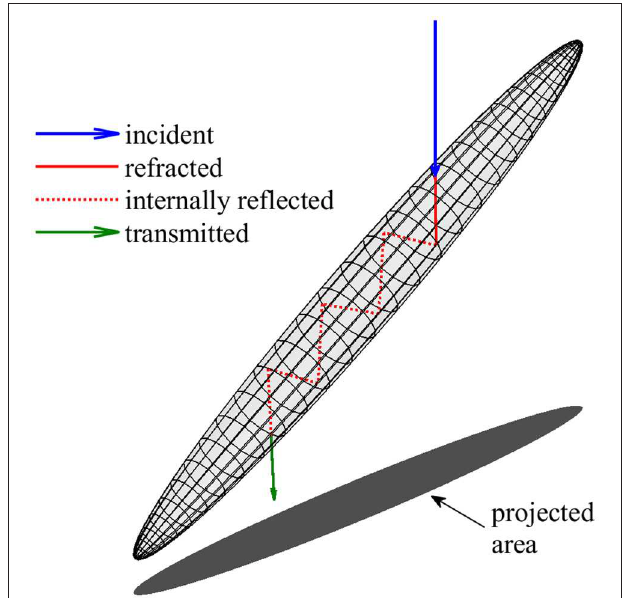
FIGURE 2 | Illustration of the geometric optics model used to estimate absorption by diatom colonies. Cells and colonies are represented by prolate spheroids with major axes, minor axes, and orientation determined from image analysis ( Figure 1 ). Modeled ray paths originated from above and included 6 internal reflections. Absorption cross section was determined from the decrease in radiant flux along internal ray paths (shown in red) and integration over the vertically projected area.